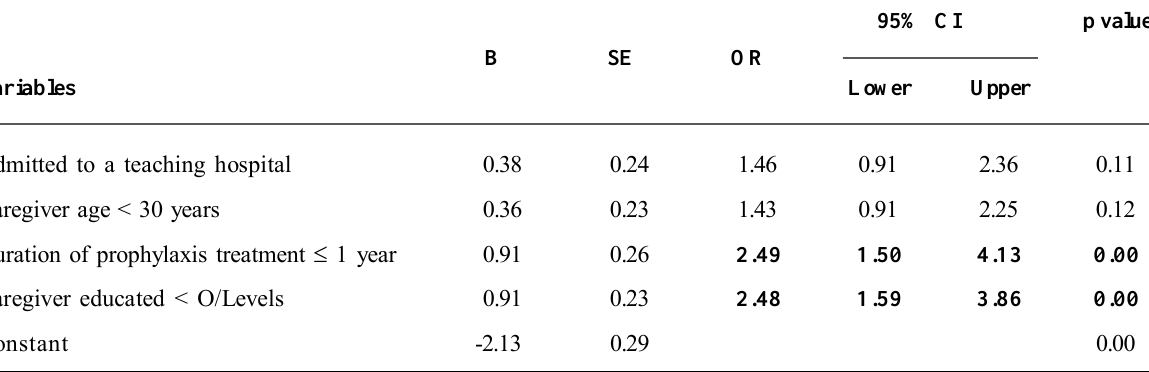
Table 5. Determinants for poor caregiver knowledge on asthma by multiple regression analysis (N =